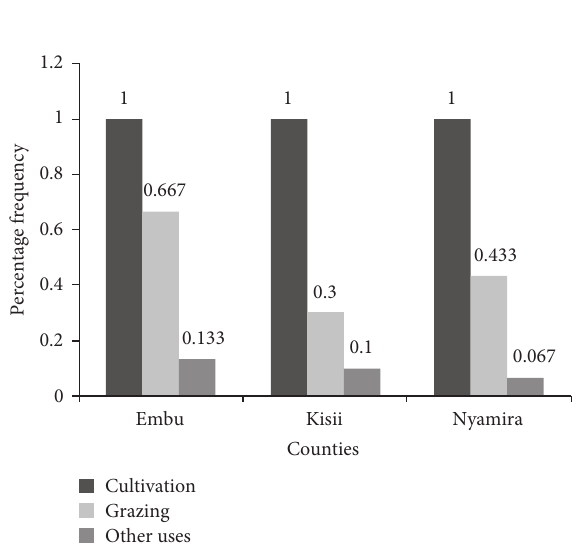
Figure 3: Mixed farming systems in Kisii, Nyamira, and Embu